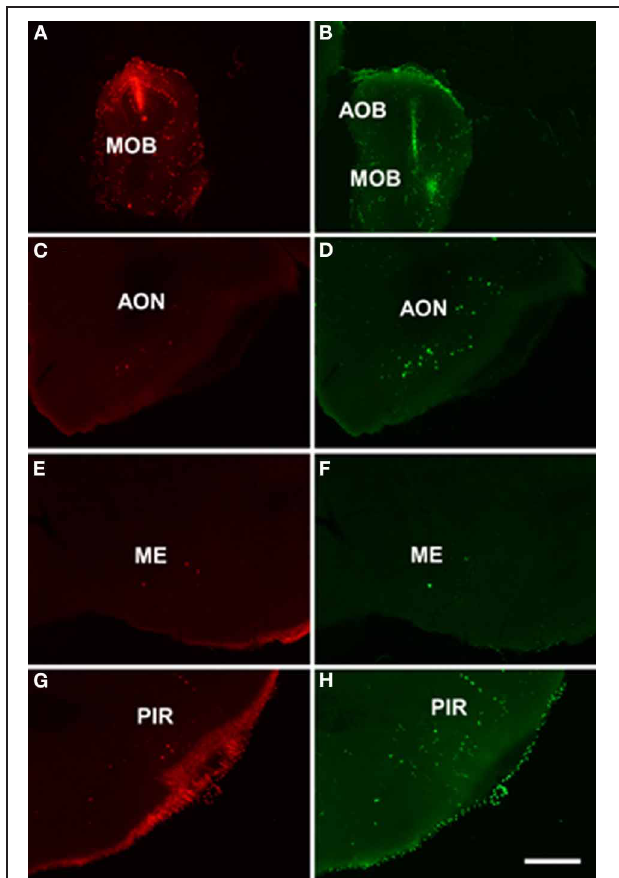
FIGURE 4 | Coronal sections from rostral to caudal levels of the telencephalic hemisphere showing the resulting labeling (C,E,G and D,F,H) after a dextran-amine labeled tetramethylrhodamine injection in the mouse main olfactory bulb (A) and a dextran-amine labeled fluorescein injection in the mouse main and accessory olfactory bulbs (B), respectively. Abbreviations: AOB, accessory olfactory bulb; AON,